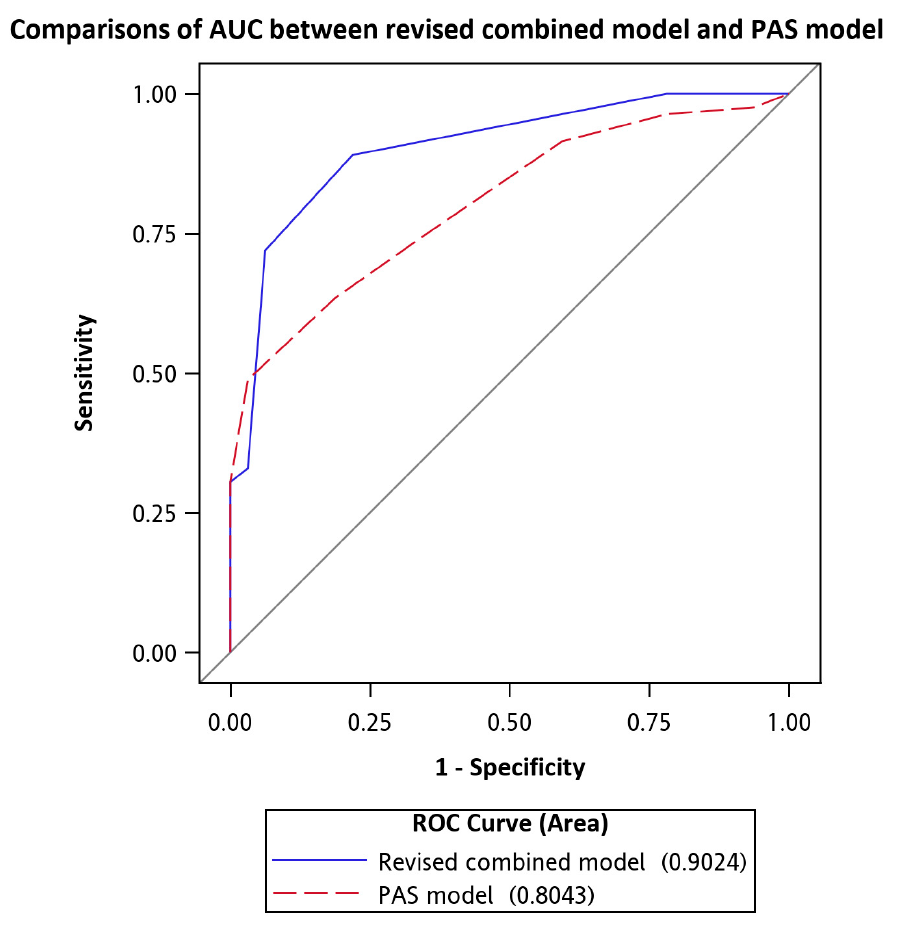
Figure 3. ROC curves for comparisons of the AUC between the revised combined model and the PAS model.